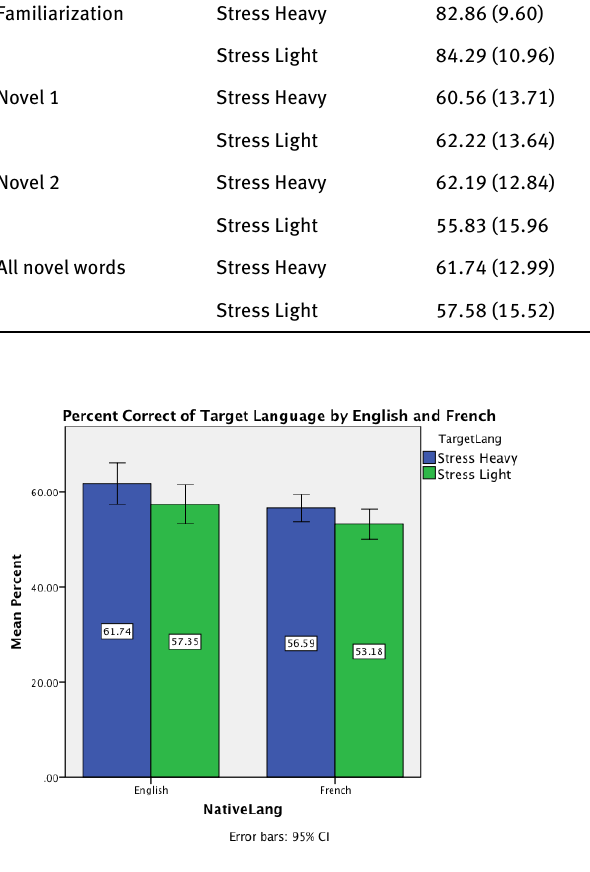
Figure 1 Percent scores of English and French performance on the Stress Heavy and Stress Light